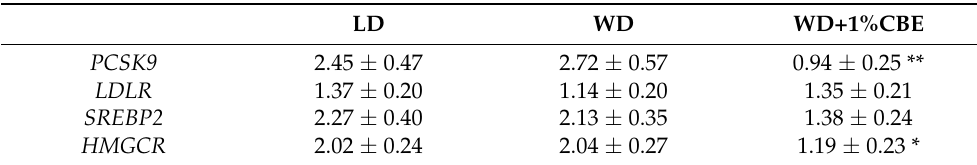
Table 2. Hepatic expression of genes, including LDLR, PCSK9, SREBP2, and HMGCR, in mice fed with LD, WD, or WD+1%CBE for 12